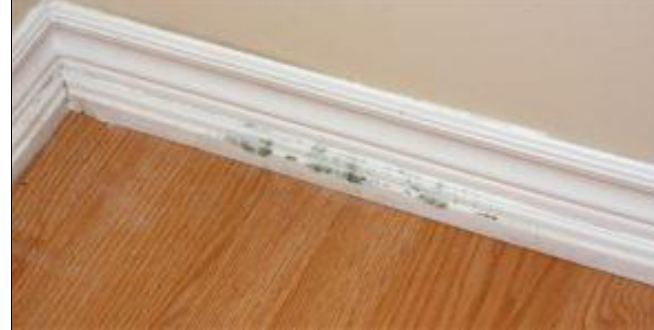
Figure 5: Mold infecting the